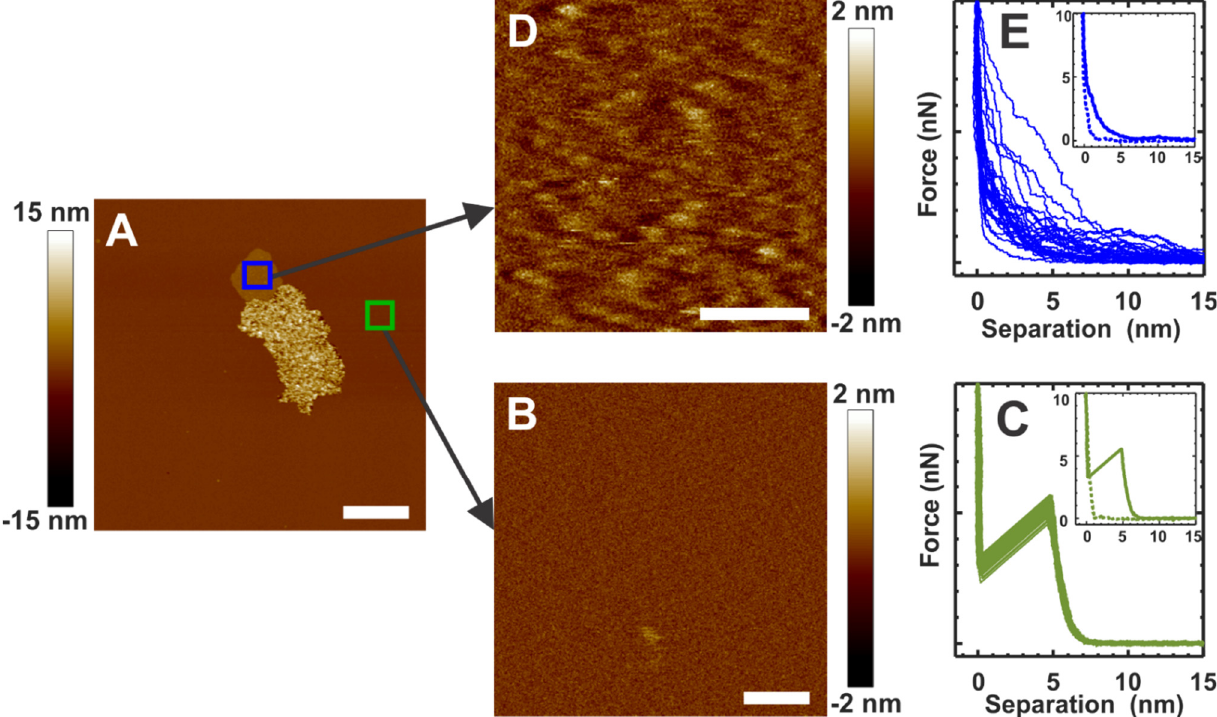
Figure 2. ( A ) α -Crystallin interacting with the SLM at around 1 h incubation time. ( B ) AFM image of the α -crystallin-free membrane region, identified by the green square in ( A ). ( C ) Representative force curves in the membrane region, as shown in ( B ). ( D ) The AFM image collected in the blue square region in ( A ) shows a closer view of the structural details of the α -crystallin membrane region with strong α -crystallin membrane interaction and the submersion of α -crystallin into the membrane. Bumps in ( D ) suggest α -crystallin oligomers submerged in the membrane. ( E ) Representative force curves for the membrane region of ( D ). Representative complete force curves are shown in ( C , E ) insets, with solid and dotted curves representing approach and retract curves, respectively. Image scales: 1 µ m for ( A ); 0.1 µ m for ( B , D